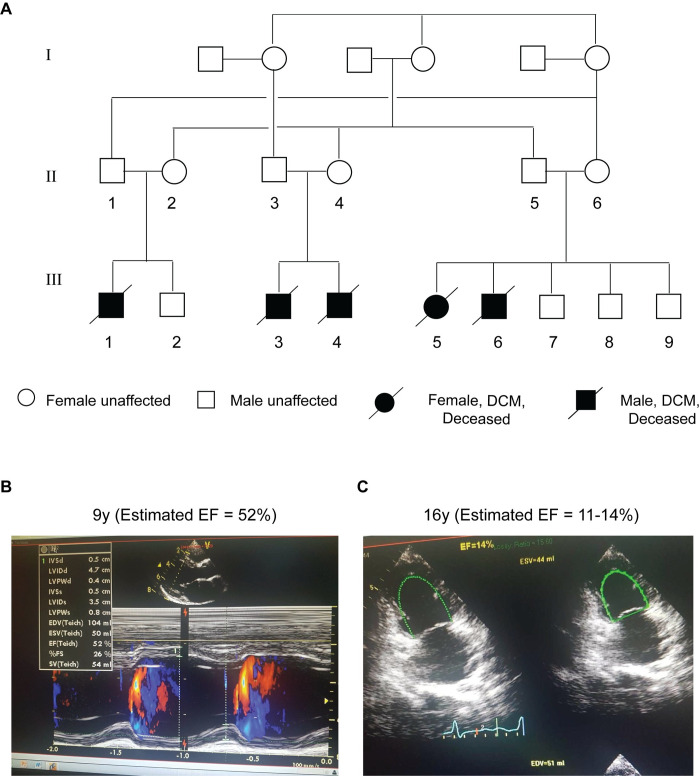
Family pedigree and DCM imaging.(A) Schematic pedigree of the consanguineous family affected by early-onset, severe DCM in an autosomal recessive pattern of inheritance. Circles represent female family members, and squares represent males. Filled symbols indicate family members diagnosed with DCM, diagonal lines indicate death. All the family members with open symbols underwent complete physical and cardiac evaluation and were found to be healthy. (B-C) Echocardiographic images of Patient III-5 showing the DCM progression. Left: an exam obtained in 2012 at the age of 9 years. M-mode tracing of the LV dimensions over time obtained in the parasternal long axis view. Estimated EF was 52% indicating mild LV dysfunction. Right: an exam obtained in 2019 at the age of 16 years few days before death. Systolic and diastolic LV dimensions are shown in apical 2 chamber view. The estimated EF in this exam was 14% indicating extremely severe LV dysfunction.